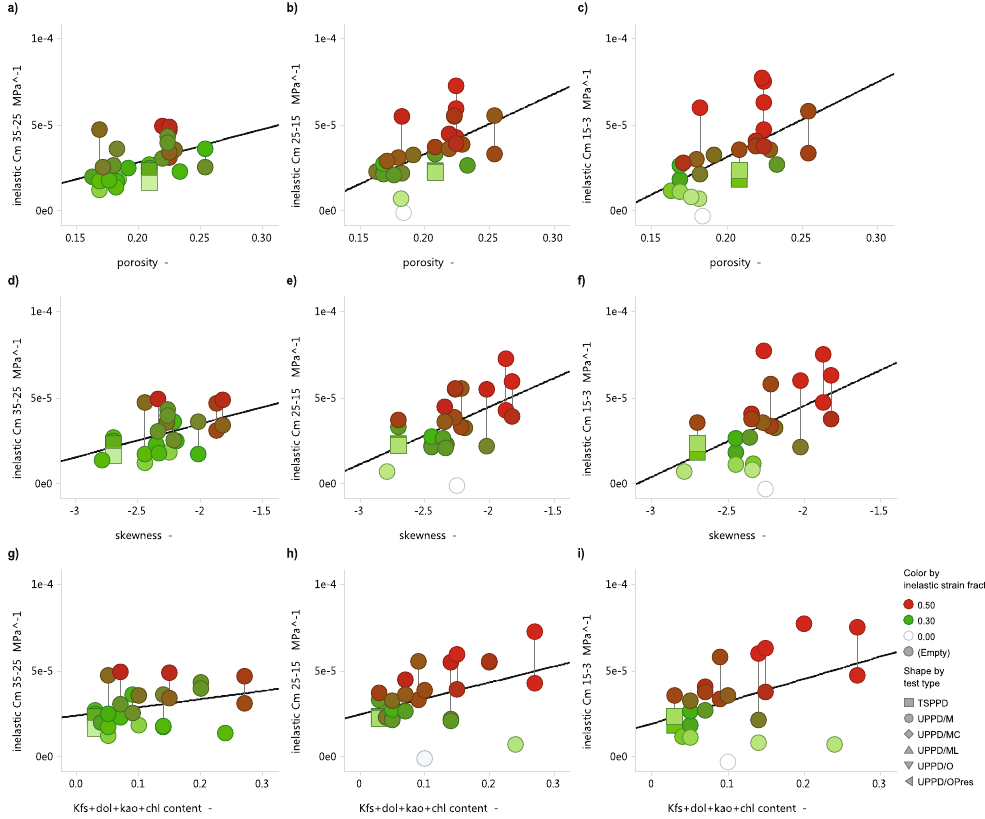
Figure 4. ( a – c ) Inelastic uniaxial-strain compressibility C m for each depletion step (pore pressures 35 MPa-25 MPa, 25 MPa-15 MPa, and 15 MPa-3 MPa), calculated by subtracting the total Cm and the elastic Cm, versus porosity. ( d – f ) Inelastic Cm for all depletion steps versus skewness of the sandstone particle size distribution. A low value of skewness means a relative abundance of fine particles in the rock particle packing, increasing the coordination number. g)-i) Inelastic Cm for all depletion steps versus the total fraction of “weak” minerals, viz. K-feldspar, dolomite, kaolinite, and chlorite minerals. Note, that the outliers at the bottom of ( h , i ) are samples with a porosity lower than 0.19. In all plots shape indicates the various loading protocols employed, with the multicycle Uniaxial-strain Pore Pressure Depletion (UPPD/M) being the most used. Color gradients indicate the fraction of inelastic strain between 0 and 0.3 (white-green), and 0.3–0.5 (gree-red). General observation is that the inelastic Cm increases with depletion, and is related to porosity, skewness, and “weak” mineral